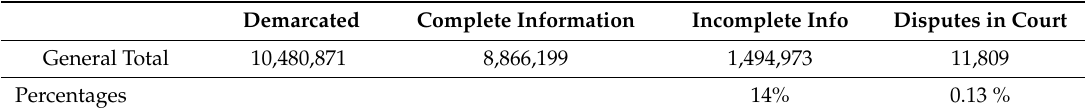
Table 2. Showing general report of Land Tenure Regularization (LTR) on disputed and unregistered land